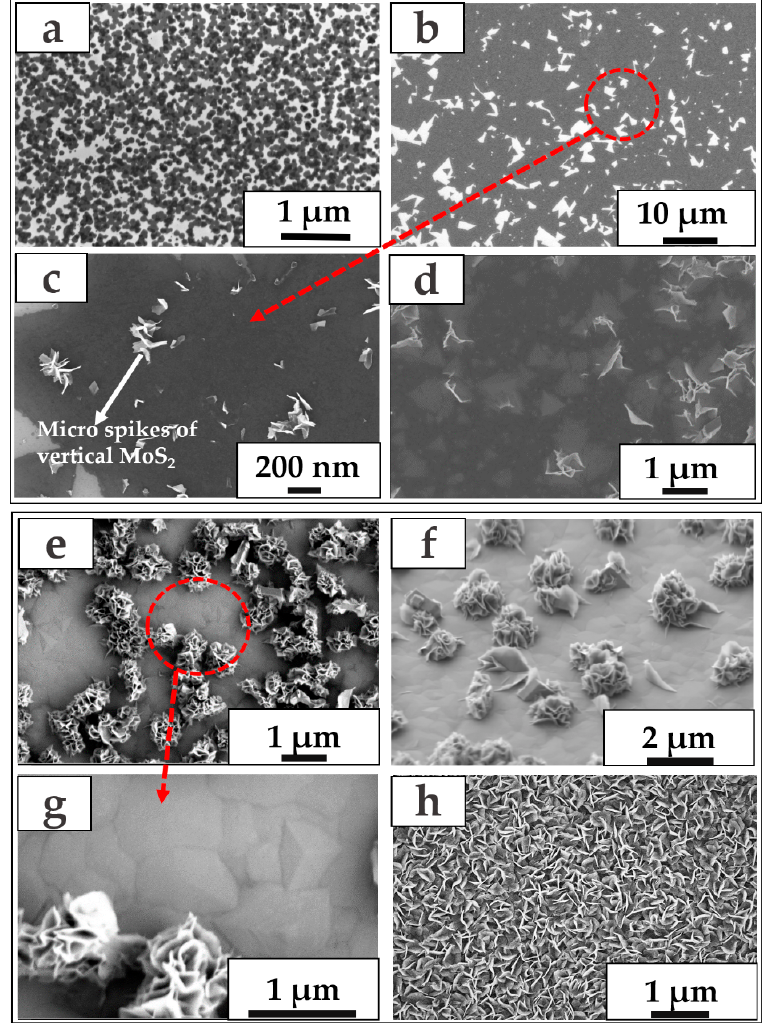
Figure 4. Growth morphology evolution of synthesized vertical MoS 2 nanosheets. ( a ) SEM images of the initial formation of nucleation domains of MoS 2 after 5 min of growth time. ( b ) Triangular-shaped MoS 2 formation after 10 min. ( c ) A magnified SEM image of triangular MoS 2 structures with micro spikes. ( d ) Formation of MoS 2 multilayered islands which cover the substrate surface after 20 min. ( e ) Formation of a three-dimensional tetrahedral MoS 2 thin film along with numerous vertical flower- like formations. ( f , g ) Tilted and magnified SEM images of material surface after 25 min. ( h ) Formation of dense flower-like vertical formations of MoS 2 structures after 30